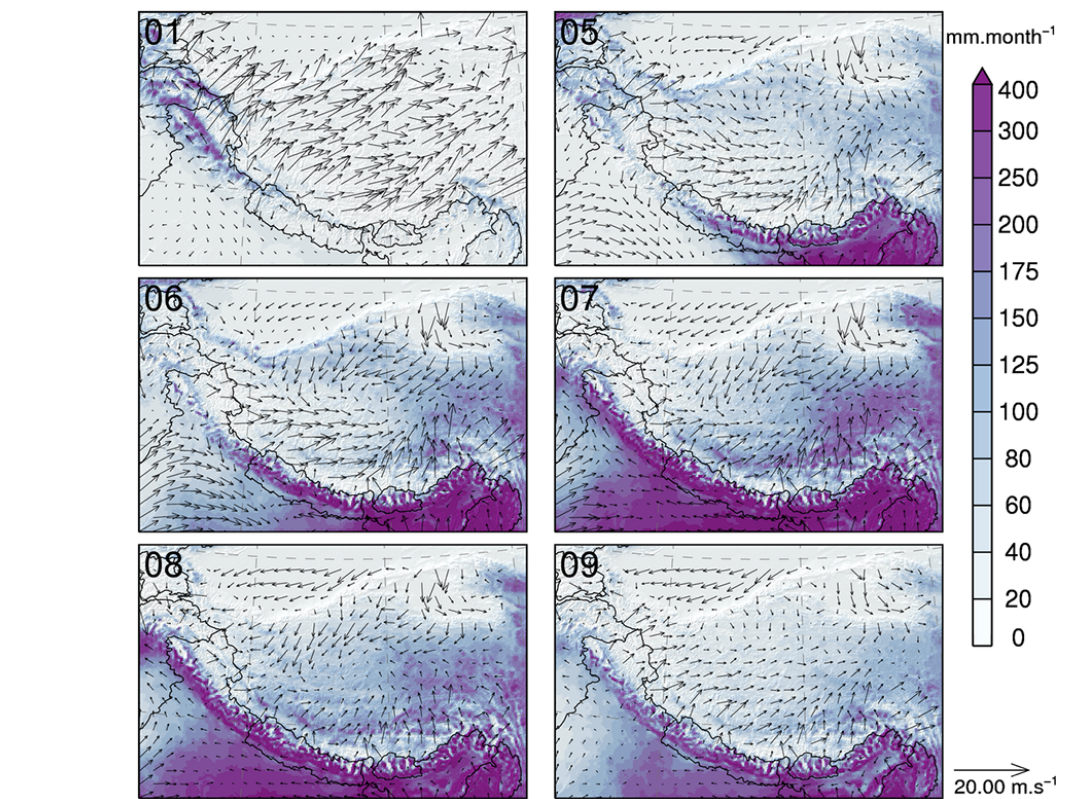
Figure 6. Decadal average of precipitation (mmmonth − 1 ) in January (01), May (05), June (06), July (07), August (08), and September (09) for HAR10. The arrows show the 10m wind field (every ninth grid point plotted).